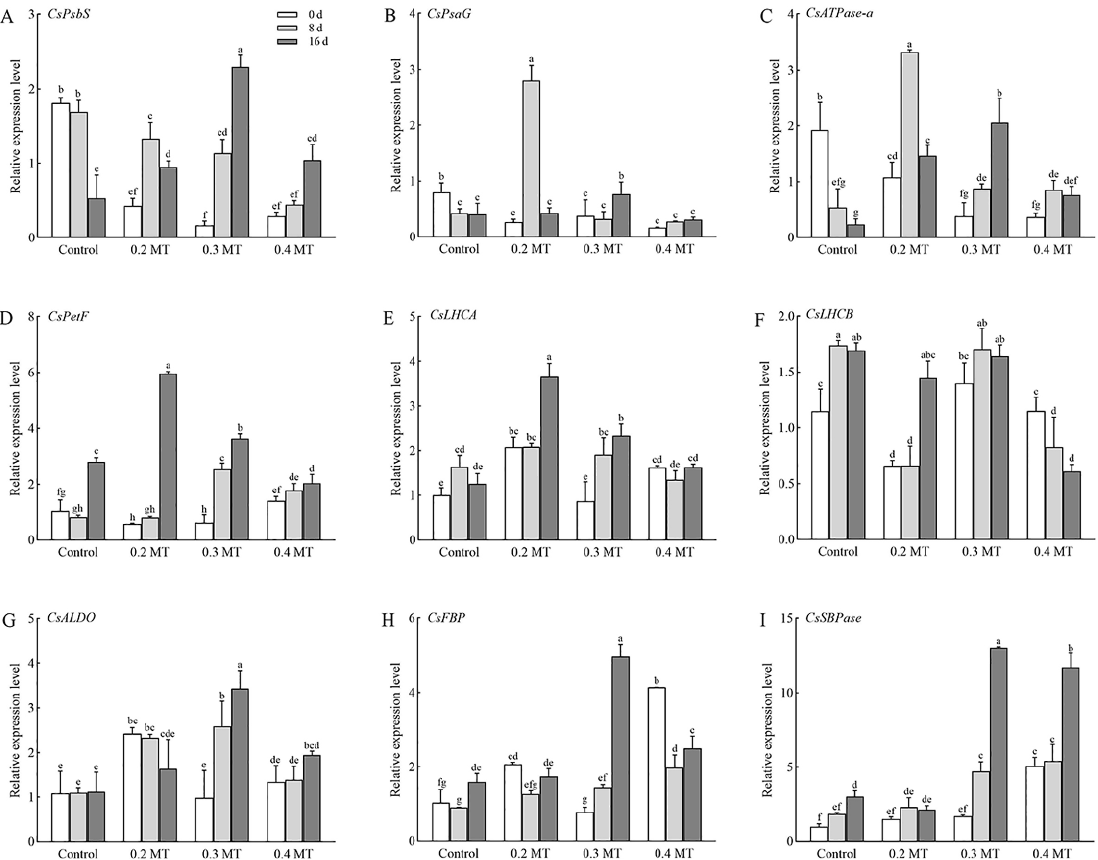
Figure 8. Expression validation based on RT-qPCR genes related to photosynthesis. ( A ) CsPsbS ; ( B